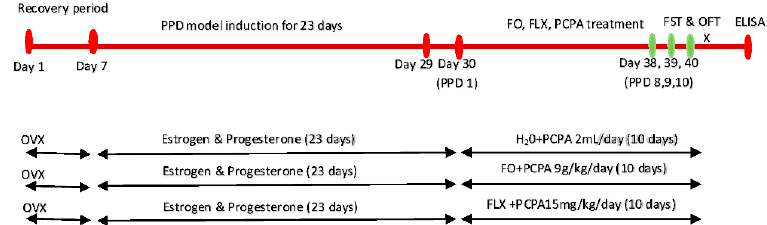
Figure 2. Experimental design for protocol 2, evaluation of FO on PPD rat model after PCPA administration. PPD—postpartum depression, FO—fish oil, FLX—fluoxetine, PCPA—p-chlorophenylalanine methyl ester, FST—forces swim test, OFT—open field test, OVX—ovariectomy, H 2 O—water,